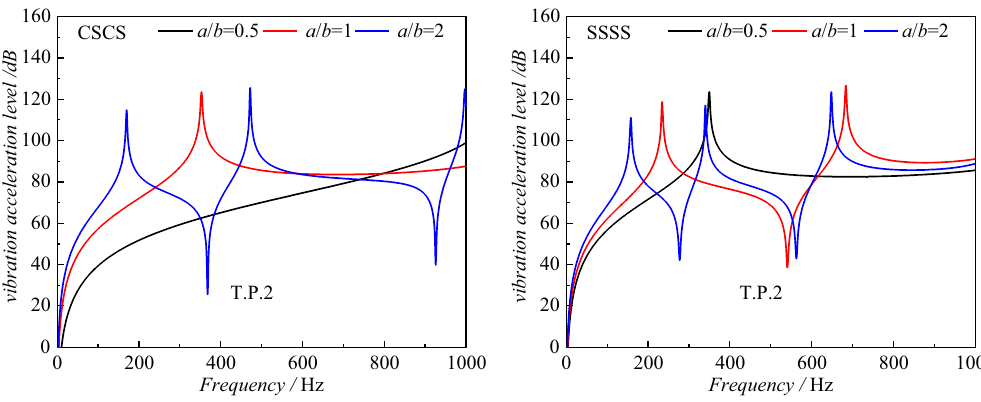
Figure 12: Comparison of the steady vibration of rectangular plate with di ff erent a / b